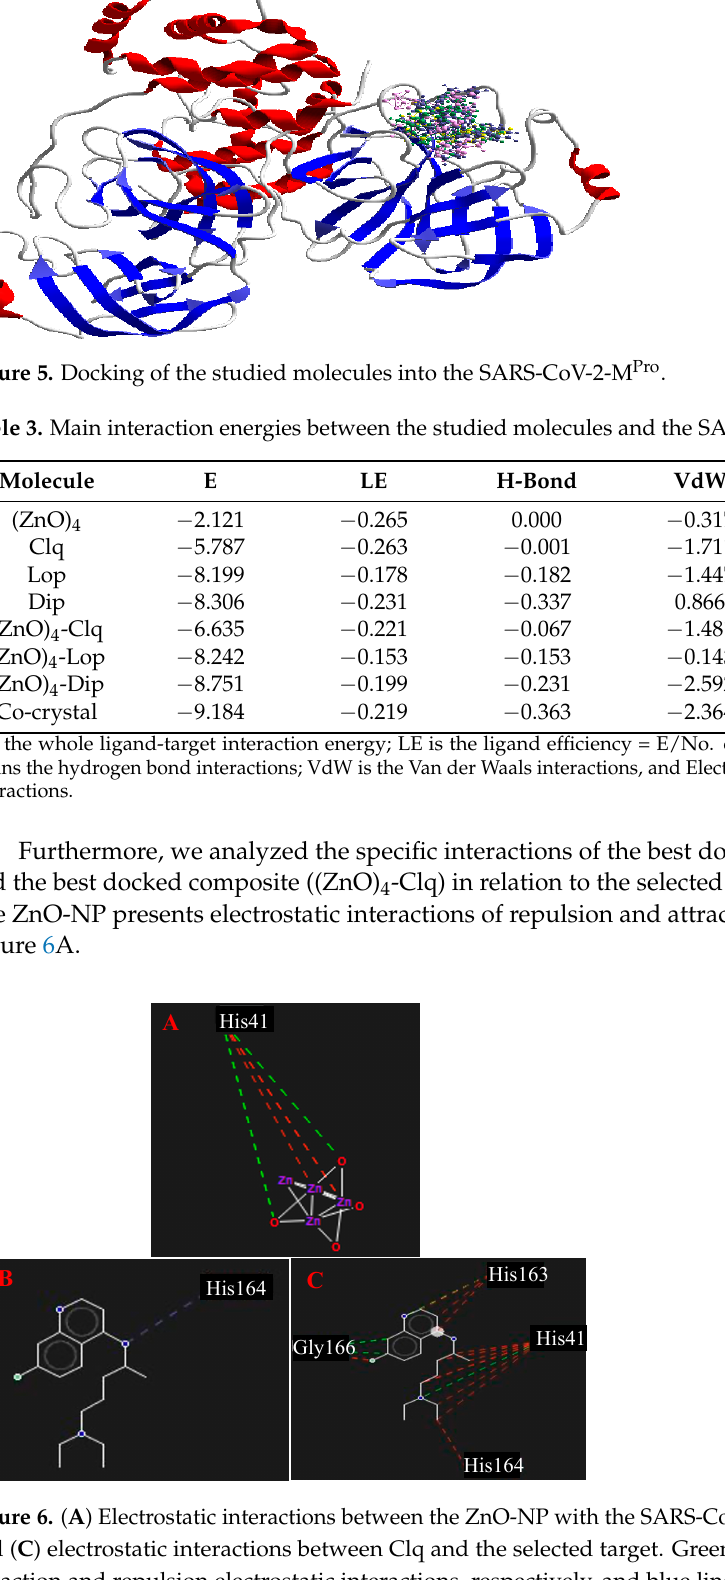
Figure 7. ( A ) H ‐ bond and ( B ) electrostatic interactions between the (ZnO) 4 ‐ Clq and the SARS ‐ CoV ‐ 2 ‐ M Pro . Green and red lines are the attraction and repulsion electrostatic interactions, respectively, and blue lines depicts the H ‐ bond interactions. 4. Discussion 4.1. Binding and Adsorption Energies Figure 1 displays an illustration of the isolated carrier cluster (ZnO ‐ NP) (see Figure 1A), and its interaction between the three selected drugs (see Figure 1B–D.) In ZnO ‐ Clq (Figure 1B), two Zn atoms of the NP are clearly in interaction with carbons and nitrogen of the Clq via hydrogen bonds or directly, which can be promoted by the structural con ‐ formation of the NO. In the case of Dip and Lop, the interaction is also between the Zn and the carbon, nitrogen and oxygen of the drugs. Furthermore, considering the E b ’s results, note that the E b is more comparative if it is calculated per atom. The molecule with the higher internal interaction is lopinavir (with 4.708 eV), due to the higher degrees of freedom promoted by its ramification on the struc ‐ ture. The lower E b /atom molecule is the ZnO ‐ NP, apparently due to the lower intramolec ‐ ular interactions and the completely inorganic molecule in Table 1 .